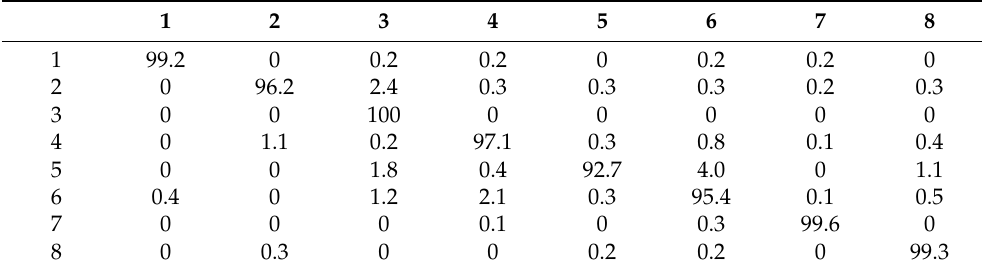
Table 3. The recognition accuracy (in %) of the financial operation type using GloVe method. In this table, 1 means shareholder operations, 2—operations with salaries, 3—return operations, 4—other operations, 5—other financial operations, 6—residual operations, 7—depreciation opera- tions, 8—sales operations.